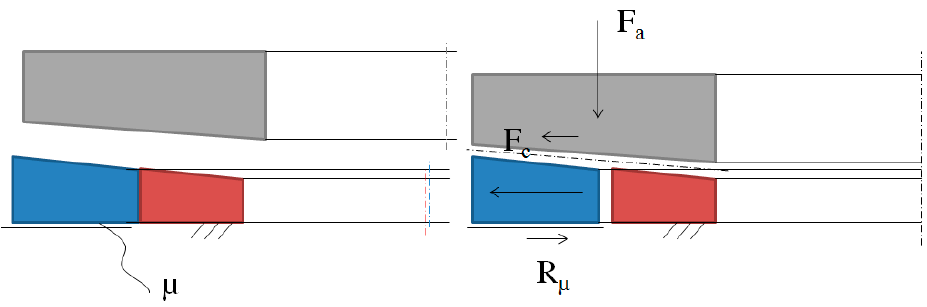
Figure 11. Hirth self-centering action.